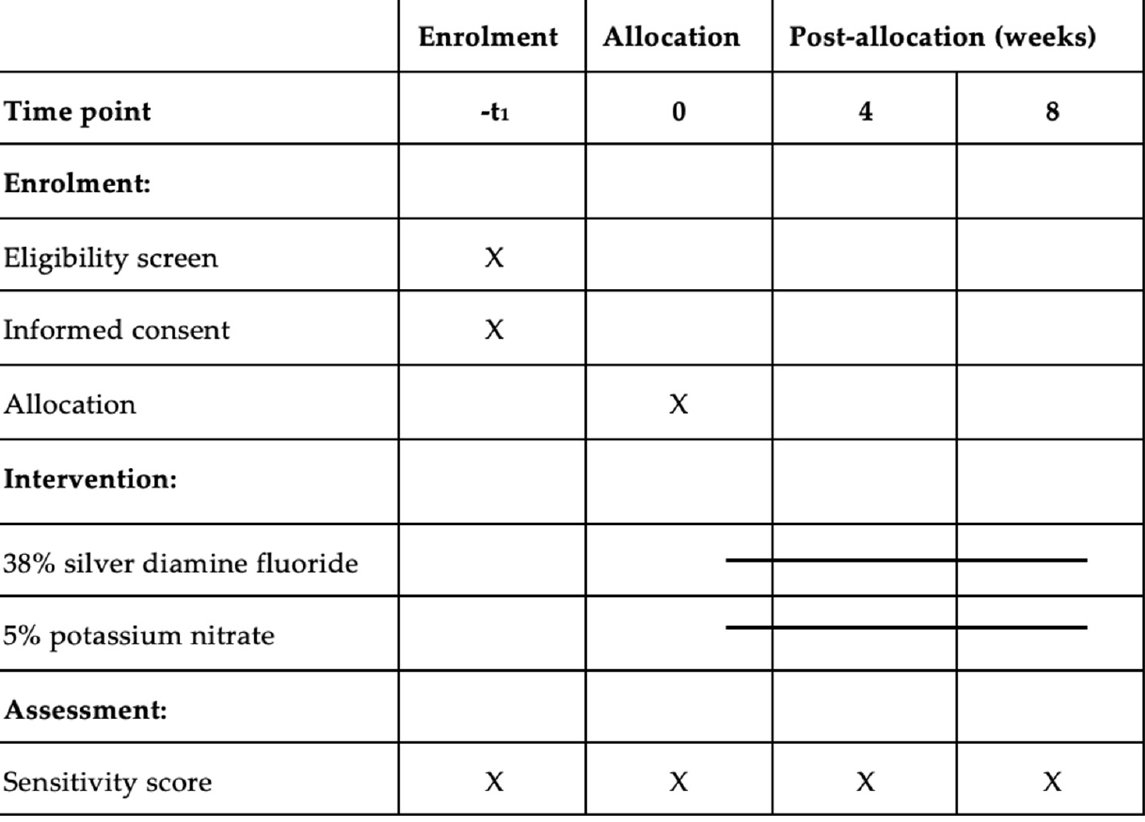
Figure 1. The schedule of enrolment, intervention and assessments.